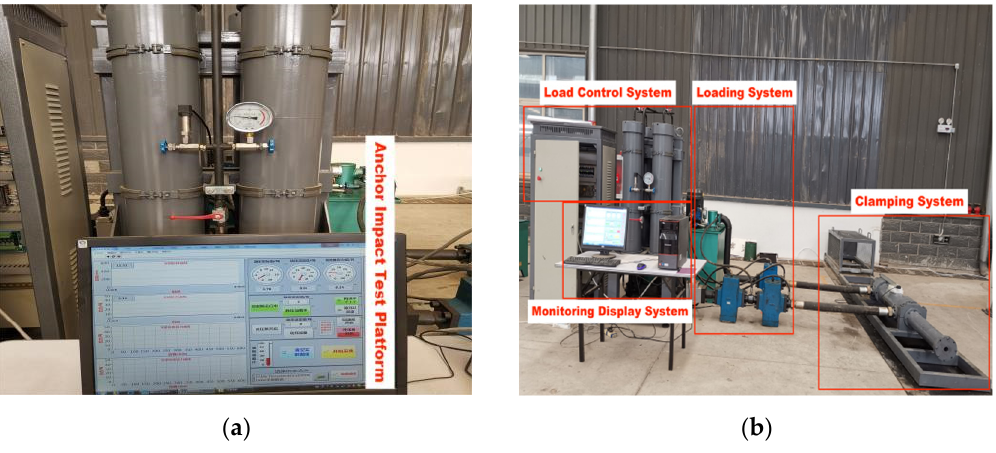
Figure 9. 300 KN anchor impact test system ( a ) Anchor impact test platform; ( b ) Anchor impact test bench.